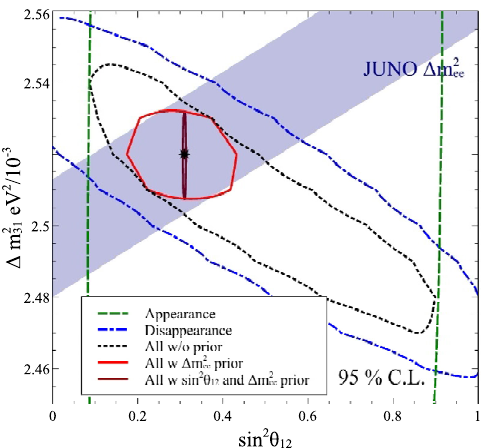
Figure 3 . The 95% C.L. expected allowed areas in the ∆ m 2 − sin 2 θ 12 plane for T2HK. The blue 31 dot-dashed contour is obtained using T2HK disappearance channel only, the green dashed curve using T2HK appearance channel only and the black dotted curve using both. The blue shaded region is the JUNO prior on ∆ m 2 . The red solid contour is obtained when we apply the prior from ee JUNO on ∆ m 2 and the dark red contour is obtained when we also add the sin 2 2 θ 12 prior along ee with the prior on ∆ m 2 ee